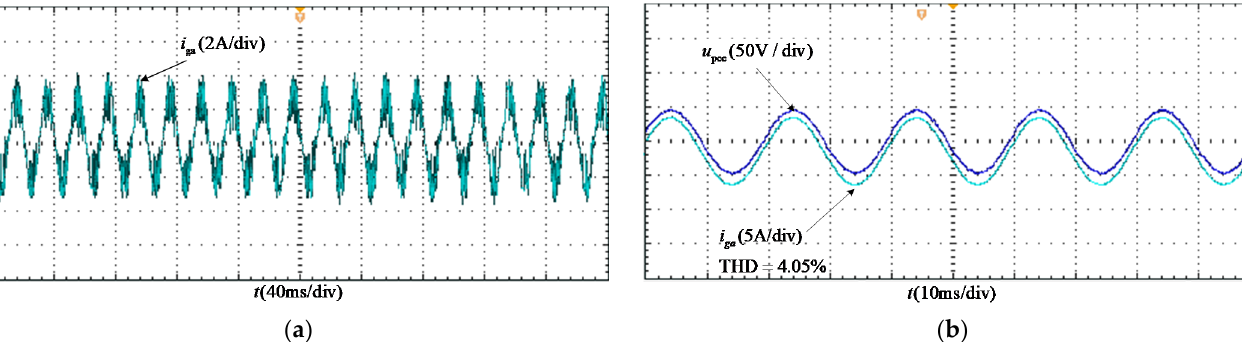
Figure 13. Experimental results under weak grid: ( a ) the grid current waveform when no delay compensation link is added; ( b ) network current and PCC voltage when delay compensation link is added.